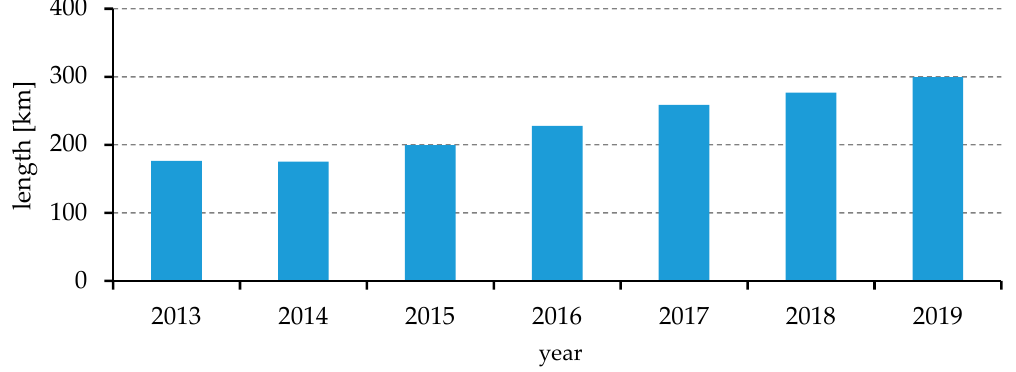
Figure 11. Total length of bus lanes in Poland. More than half of the bus lanes, i.e., 151.4 km, are allotted out only in four cities: Warsaw, Kraków, Wroc ł aw, and Ł ód ź , of which 68.9 km (46%) is located in Warsaw (Figure 12).